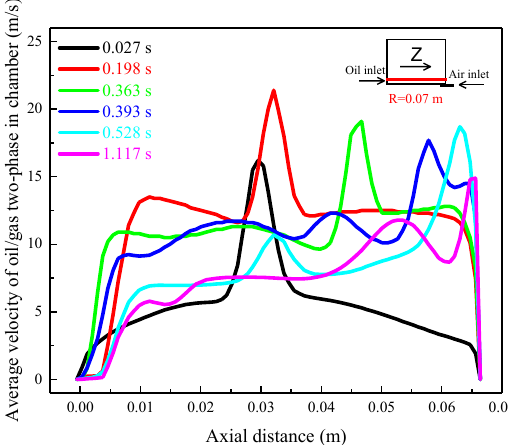
Figure 12. Axial velocity of oil/gas at 10,000 rpm.